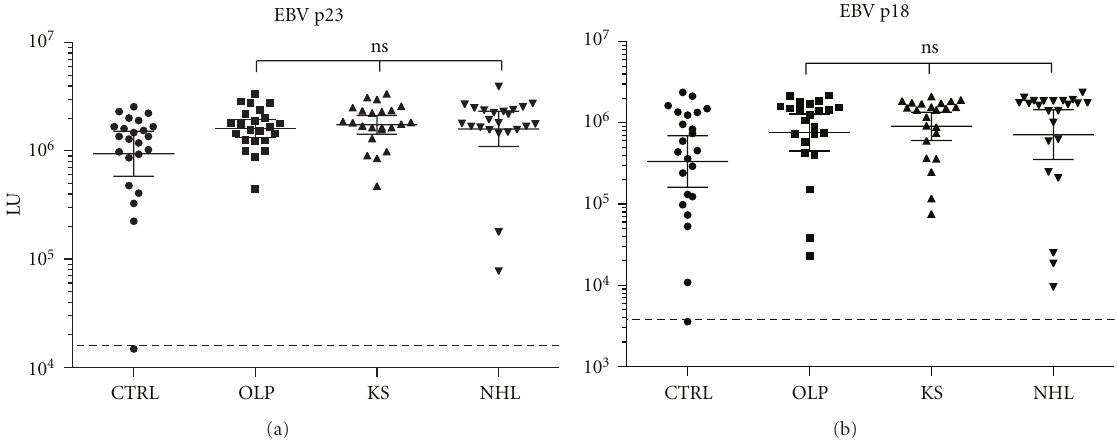
Figure 2: Anti-p23 and p18 antibodies in the uninfected blood donors and HIV-infected subjects. The geometric mean titer and 95% CI for (a) p23 and (b) p18 EBV antibodies in the 23 control blood donors, 23 OLP, 23 KS, and 23 NHL subjects were plotted on the Y -axis using a log 10 scale. Each symbol represents a sample from one individual. The dashed line represents the cut-o ff level for determining seropositivity. P values for the di ff erent groups were calculated using the Mann Whitney U